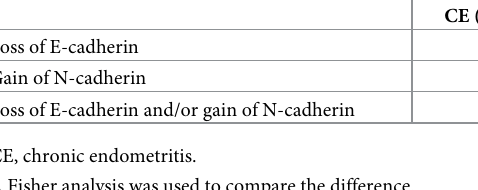
Table 2. The association between chronic endometritis and the cadherin expression profiles in the specimens.